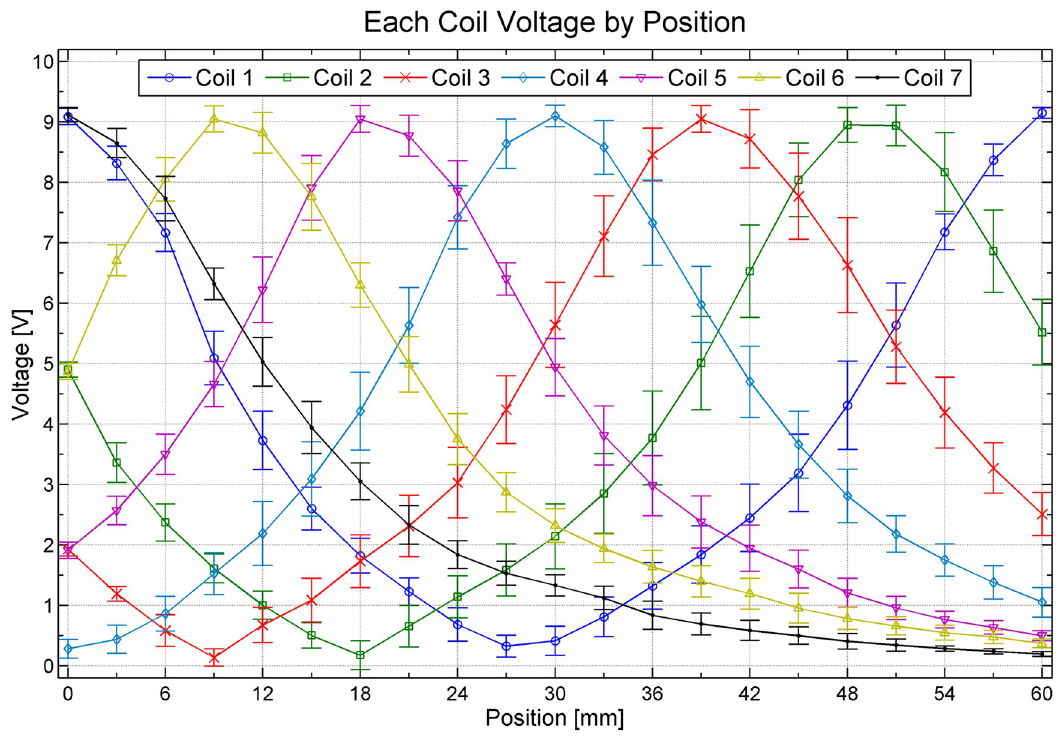
Fig 9. Result graph of measured voltage at Fig 7 circuit output(ADC